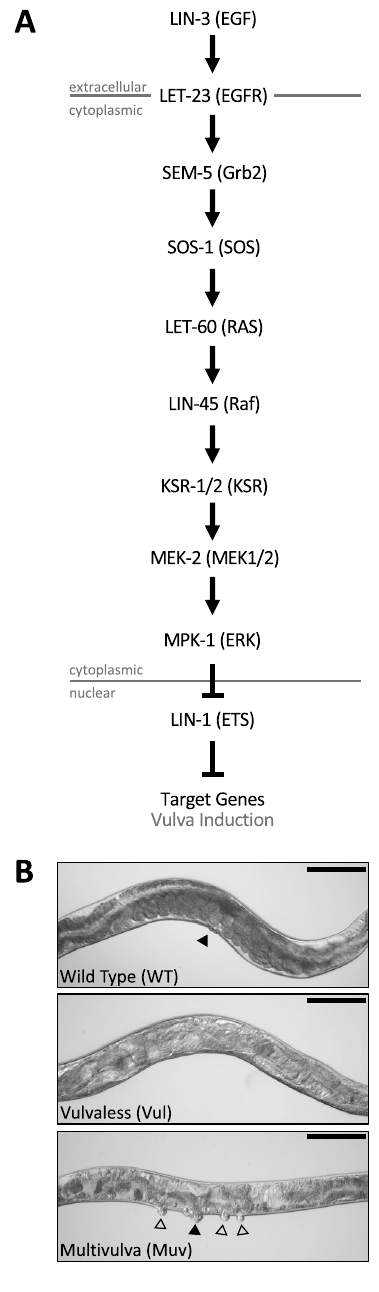
Figure 3. The conserved C. elegans EGFR/Ras/MAPK pathway controls vulval induction signaling. ( A ) A schematic of the conserved EGFR signaling pathway in nematodes. The vertebrate orthologs for each pathway component are shown in brackets. Changes in signaling levels through this pathway result in the Vulvaless (Vul) and Multivulva (Muv) vulva induction phenotypes shown in ( B ). Filled arrows indicate primary functional vulva, clear arrows indicate ectopic vulval protrusions. Scale bar 0.1